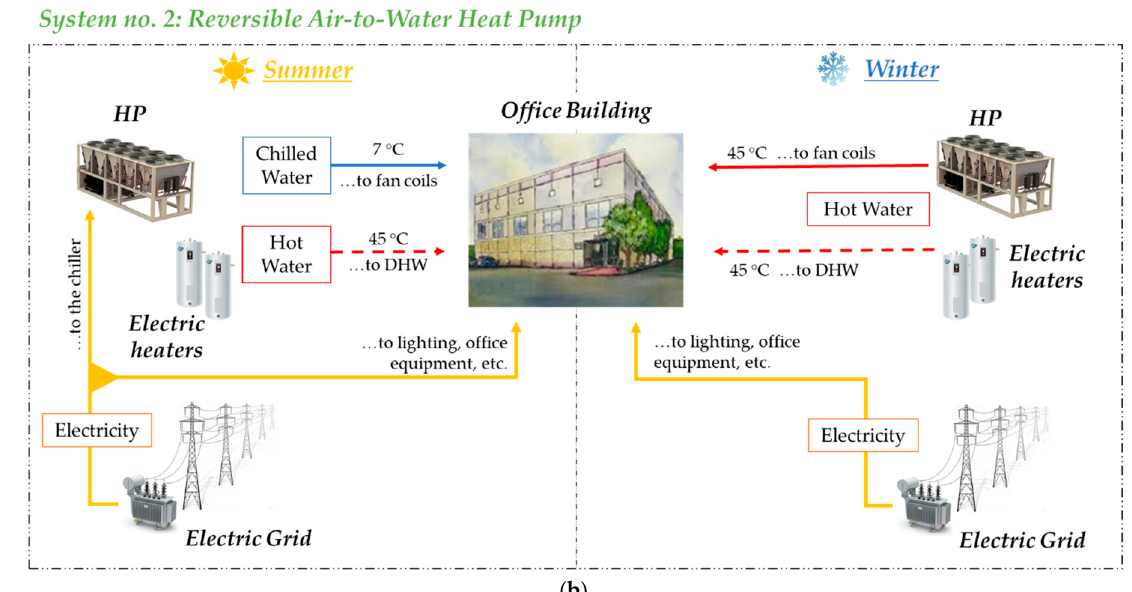
Figure 6. Schemes of the reference plants assumed for the case study: ( a ) System no. 1: NG boiler and air-cooled chiller, and ( b ) System no. 2: reversible heat pump.